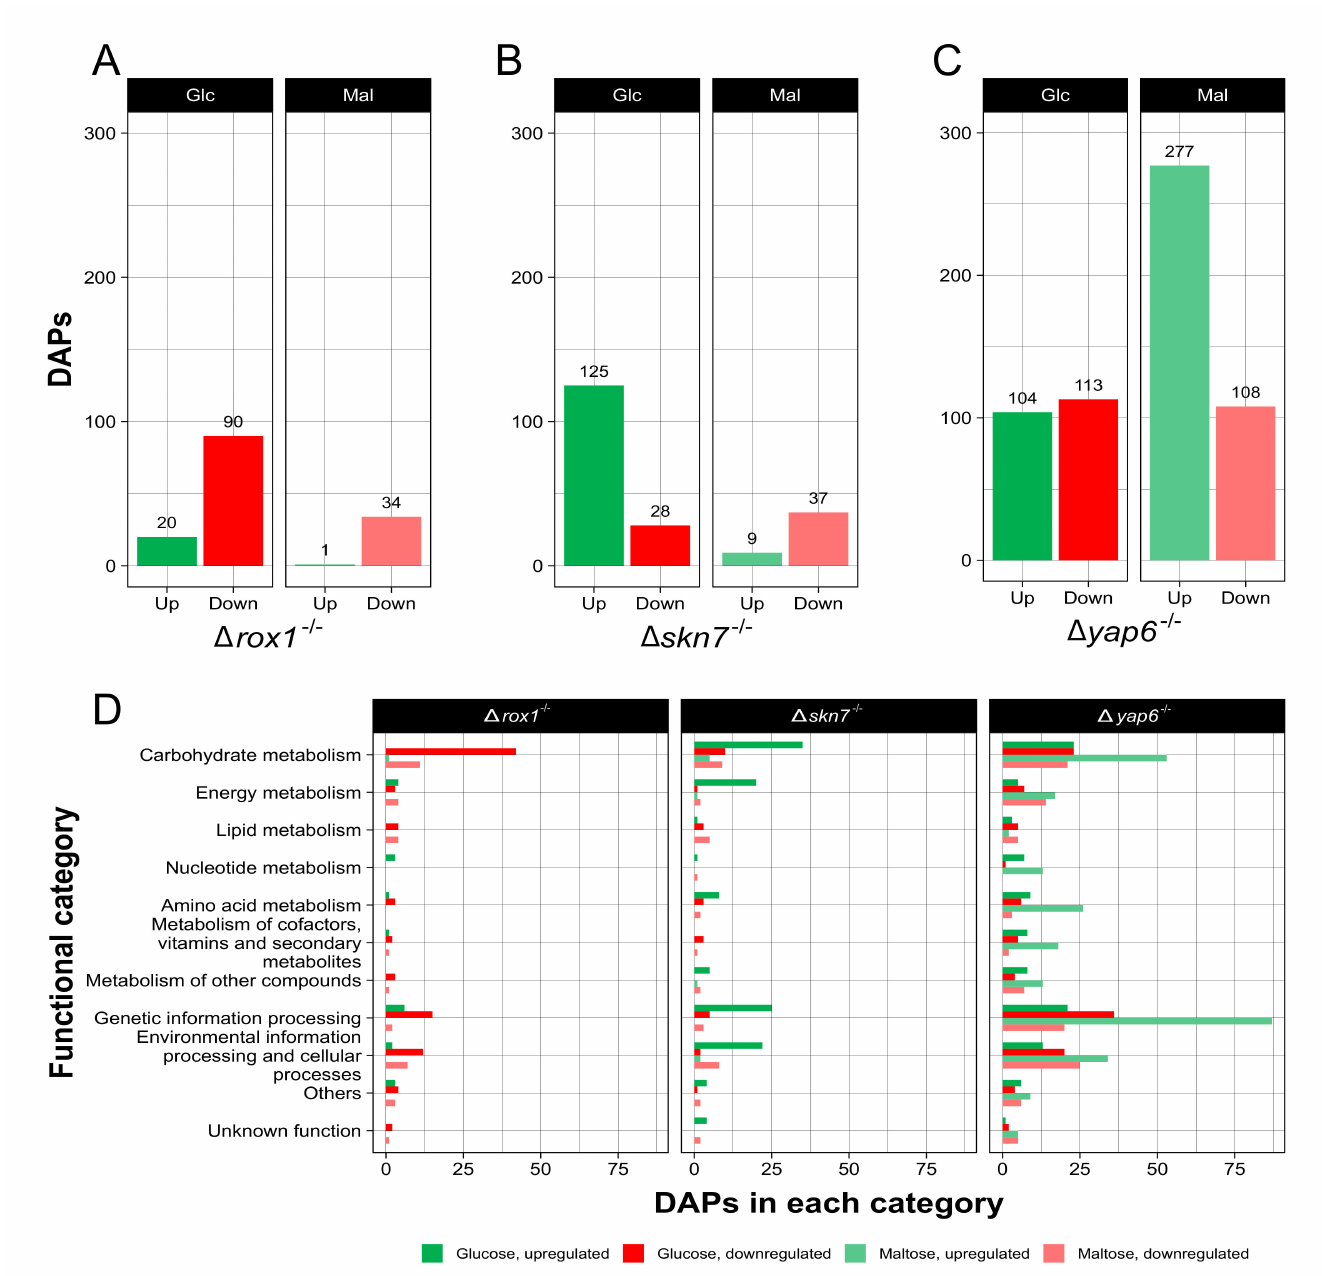
Figure 4. Differentially abundant proteins (DAPs) of ∆ rox1 − / − , ∆ skn7 − / − , and ∆ yap6 − / − strains in X. dendrorhous . Mutant strains grown in glucose or maltose were compared with the wild-type strain grown in glucose or maltose, respectively. Data representing DAPs whose levels were increased or decreased by maltose or glucose treatment. DAPs were determined by FDR p value ≤ 0.05. The bar plots show the total DAPs identified for the ∆ rox1 − / − ( A ), ∆ skn7 − / − ( B ), and ∆ yap6 − / − ( C ) strains in each condition. The horizontal bar plot shows the total DAPs in each functional category based on ortholog annotation in the KEGG public database ( D ). Upregulated DAPs (green for glucose, light green for maltose) indicate increased levels in the mutant strain, while downregulated DAPs (red for glucose, light red for maltose) indicate decreased levels in the mutant